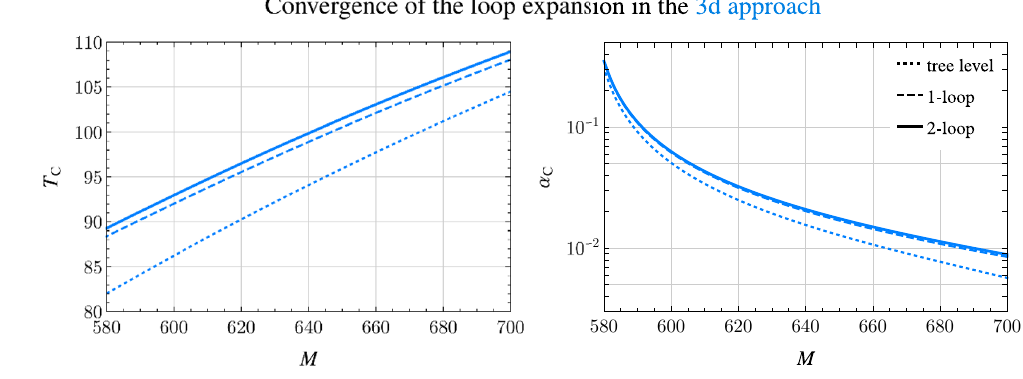
Figure 8 . Convergence of the loop expansion in the 3d effective field theory at tree-level (dotted), one-loop (dashed), and two-loop (solid) showing the purely equilibrium quantities T c and α c = α ( T c ). The discussion of the nucleation rate is left to section